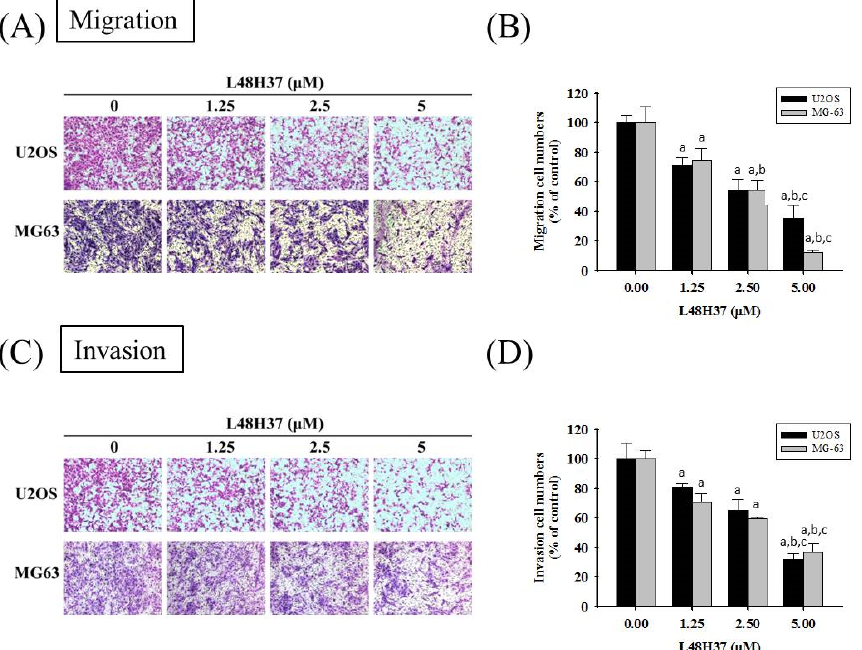
Figure 2. Effects of L48H37 on the in vitro cellular migration and invasion of U2OS and MG-63 cells. Cell migration ( A , B ) and invasion ( C , D ) assays after various concentrations (0, 1.25, 2.5, and 5 µ M) of L48H37 treatment for 24 h in U2OS and 48 h in MG-63 cells were measured, as described in the Materials and Methods section, and illustrated after quantitative analysis. Results are shown as mean ± SD. N = 3. ANOVA with Tukey’s post-hoc test was used. Migration: U2OS: F = 50.518, p < 0.001; MG-63: F = 70.589, p < 0.001. Invasion: U2OS: F = 51.441, p < 0.001; MG-63: F = 83.112, p < 0.001. a Significantly different, p < 0.05, compared with control. b Significantly different, p < 0.05, compared with 1.25 μ M. c Significantly different, p < 0.05, compared with 2.5 μ M.